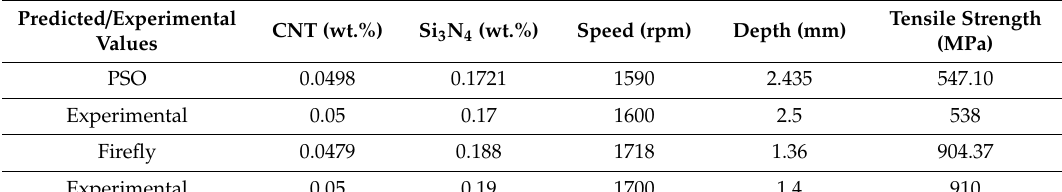
Table 6. Comparison between the values predicted using various algorithms (PSO and FFA) with the experimental values of the FWTPET + FSP technique.